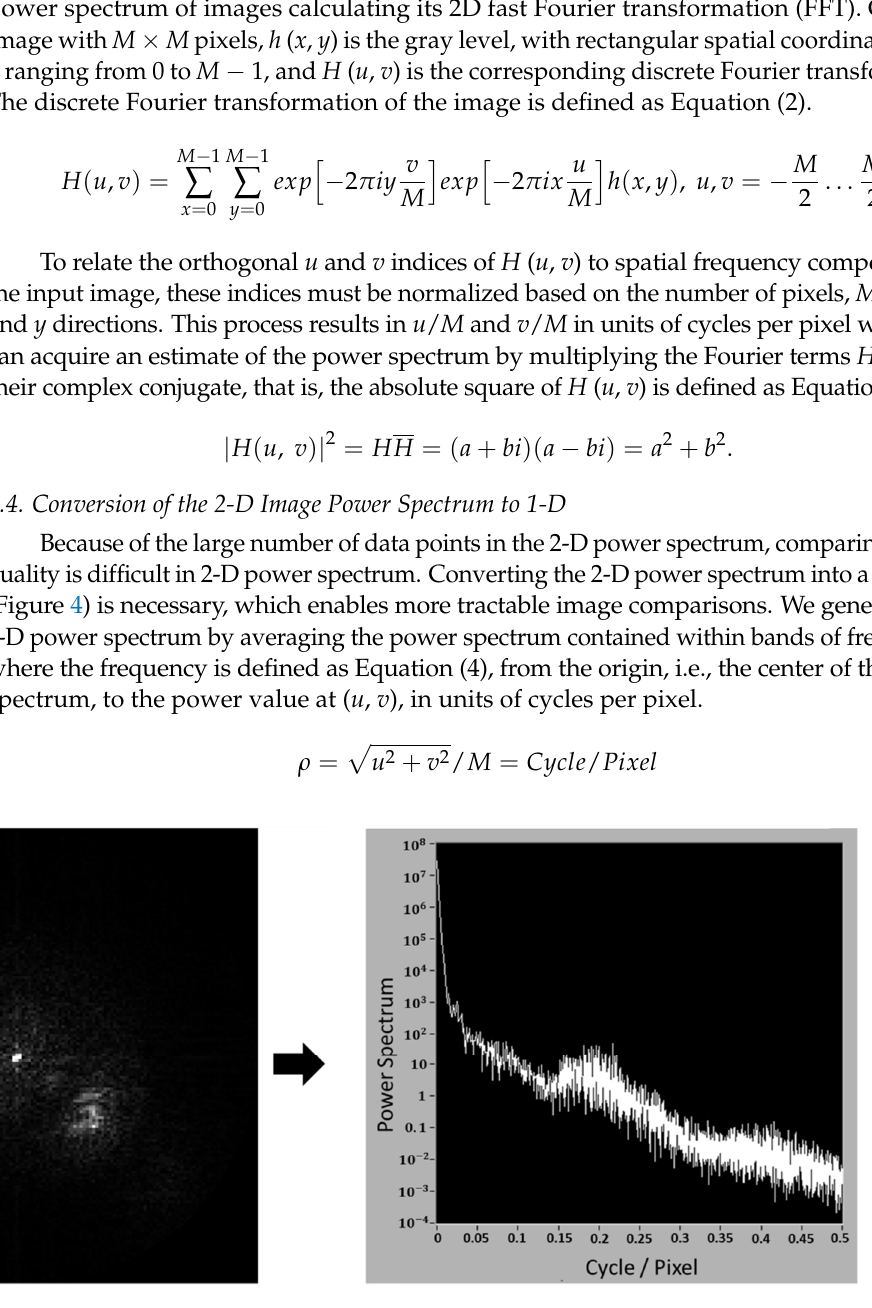
Figure 4. Conversion of the 2-D Image Power Spectrum to 1-D.